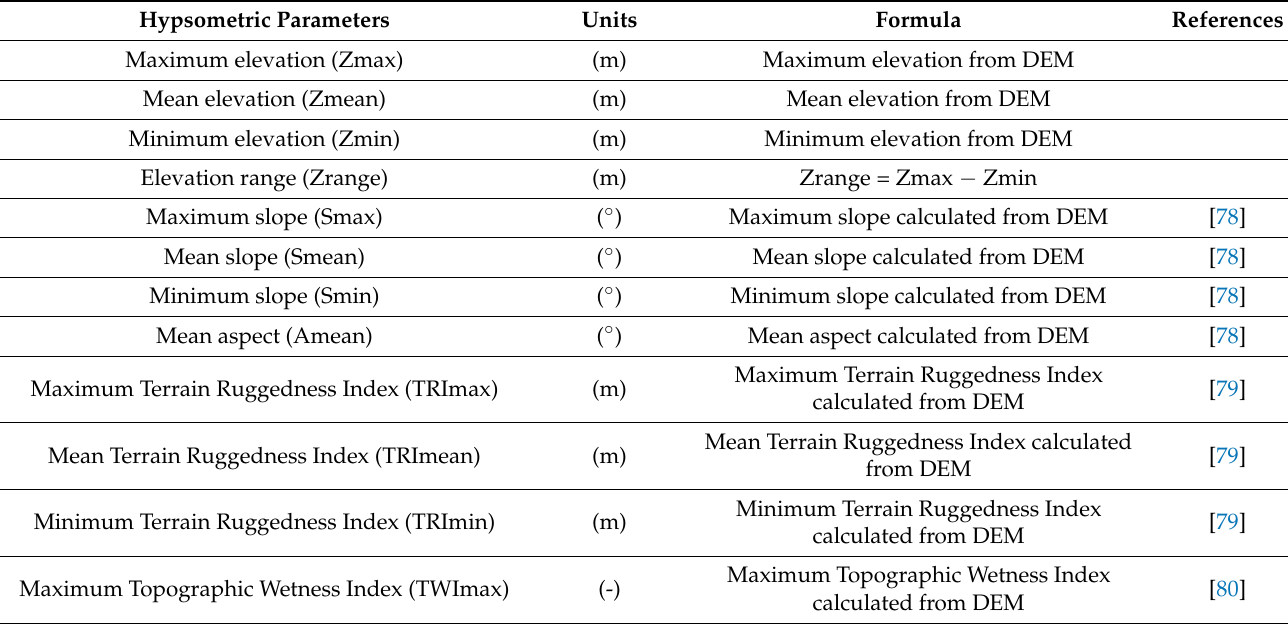
Table 4. Definition of hypsometric